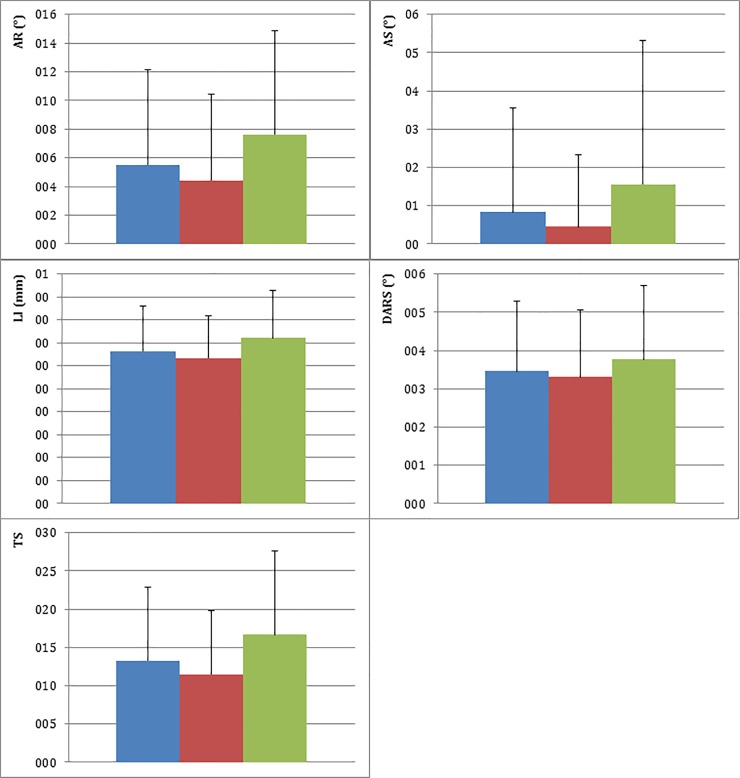
Values of the parameters at the time of early evaluation.1: AR (°), 2: AS (°), 3: LI, 4: DARS (°), and 5: TS. The blue bars represent the entire population: the red bars, the FCI A group: and the green bars, the FCI B group. * Significant difference in the evaluated parameters between the FCI A and B groups.